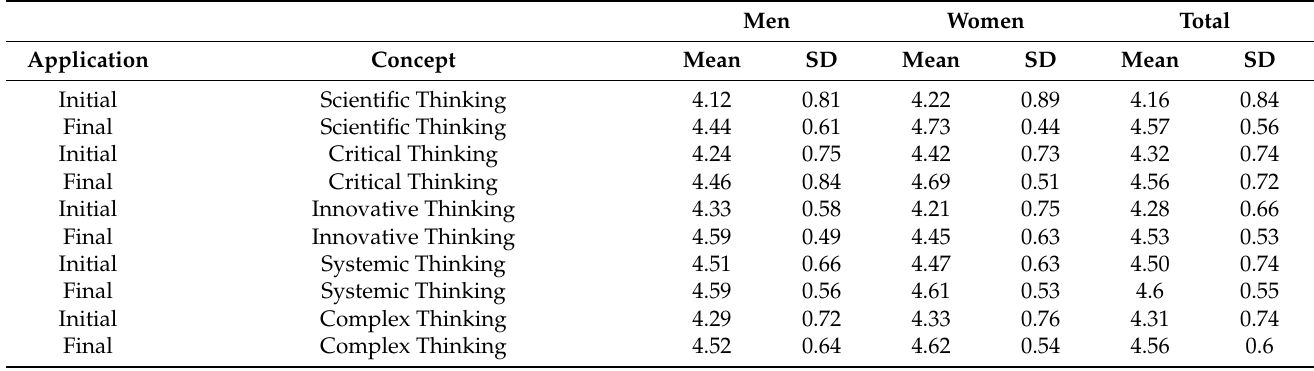
Table 5. Results of the complex thinking competency and its sub ‐ competencies (Initial–Final).